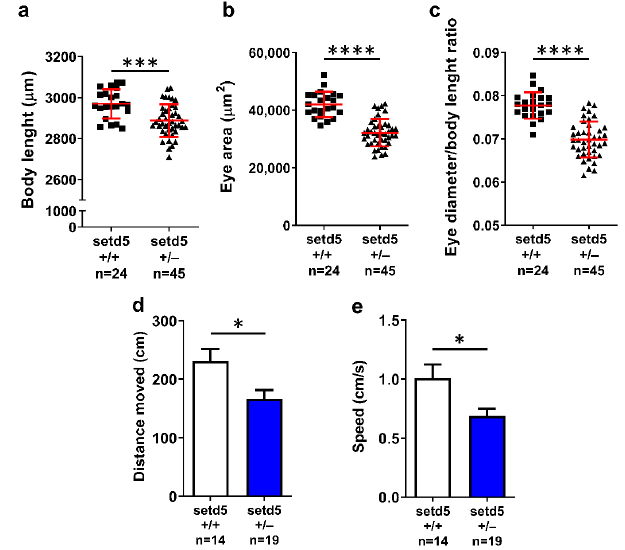
Figure 4. setd5 haploinsufficiency impairs the growth in mutant zebrafish embryos. ( a ) Body length, ( b ) eye area and ( c ) eye diameter/body length ratio analysis in setd5 +/+ and setd5 +/ − embryos at 2 days post fertilization (dpf). ( d ) Distance moved and ( e ) speed of setd5 +/+ and setd5 +/ − larvae at 6 dpf evaluated during a 5-min-long open field test. ( a – e ) Statistical analysis was performed using the Student’s t -test. Data are expressed as mean ± SEM; n = number larvae analyzed. * p < 0.05; *** p < 0.001; **** p < 0.0001.